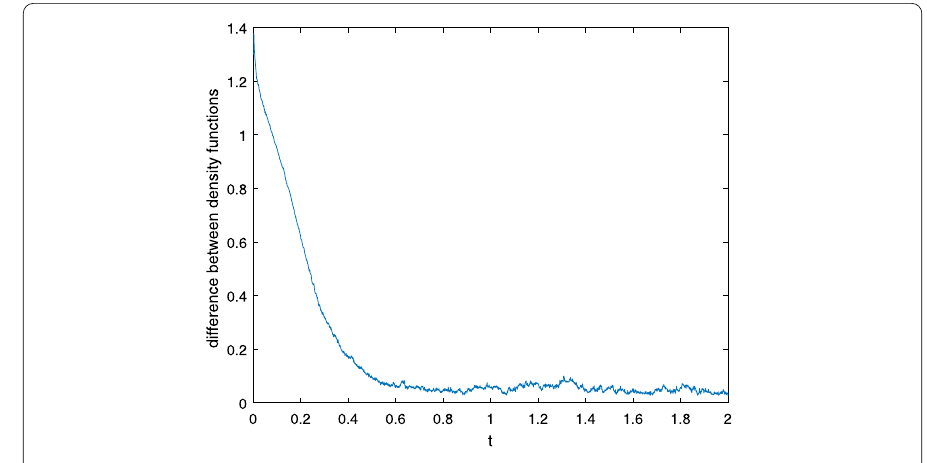
Figure 6 The difference between two adjacent empirical probability density functions for the two-dimensional equations after switching